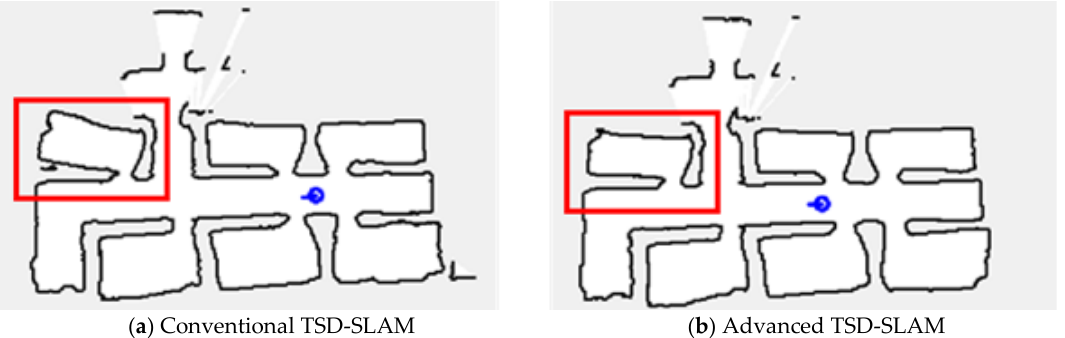
Figure 5. Comparison of the conventional TSD-SLAM and the advanced TSD-SLAM: ( a ) bent map in the red box (matching failure occurs in reactive situations); ( b ) issue resolved.